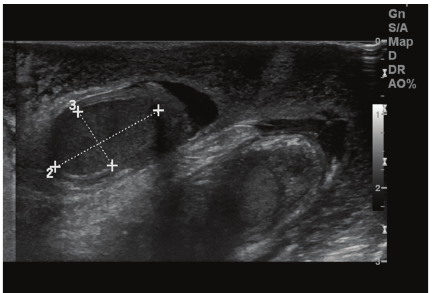
Figure 1: Ultrasound showing marked edematous scrotal skin thickening, small bilateral hydroceles, and normal appearing testes.